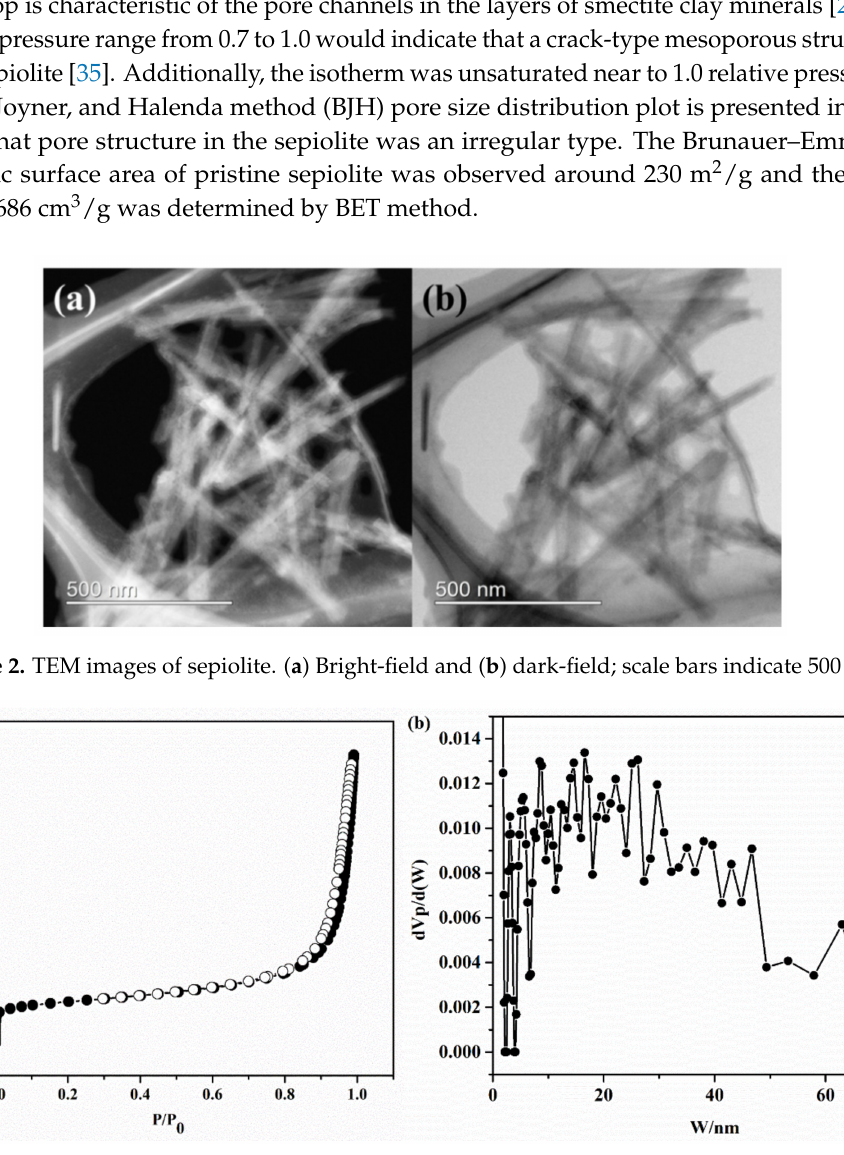
Figure 3. ( a ) Nitrogen adsorption-desorption isotherm and ( b ) BJH pore size distribution for